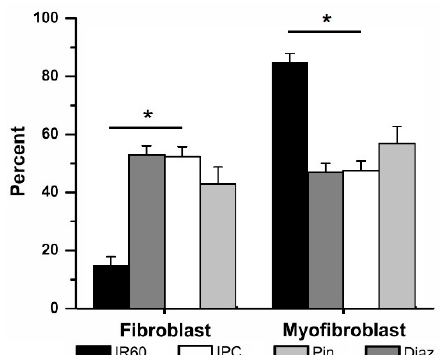
Figure 6. Ischemic preconditioning ( IPC) could be mimicked by activating K ATP channels with the non-specific opener pinacidil (Pin) and the mK ATP – selective opener diazoxide (Diaz). Replacing IPC with Pin (50 μ M) or Diaz (100 μ M) attenuated ischemia reperfusion (IR)-induced fibroblast to myofibroblast differentiation. * p < 0.05, IR vs. IPC and Diaz. The relative percentages of fibroblasts vs. myofibroblasts in IPC, Pin and Diaz were not significantly different.